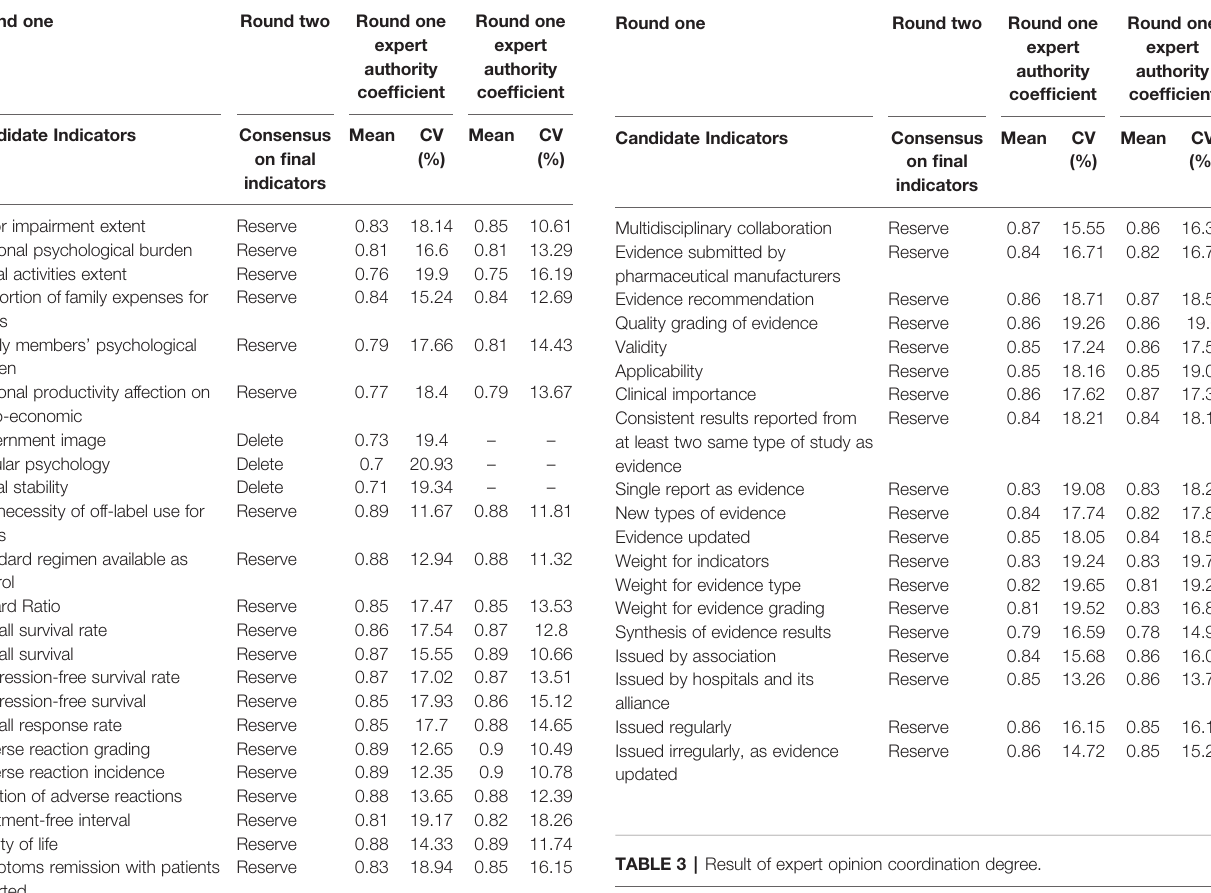
TABLE 2 | Comparison of expert authority degree with two Delphi rounds.